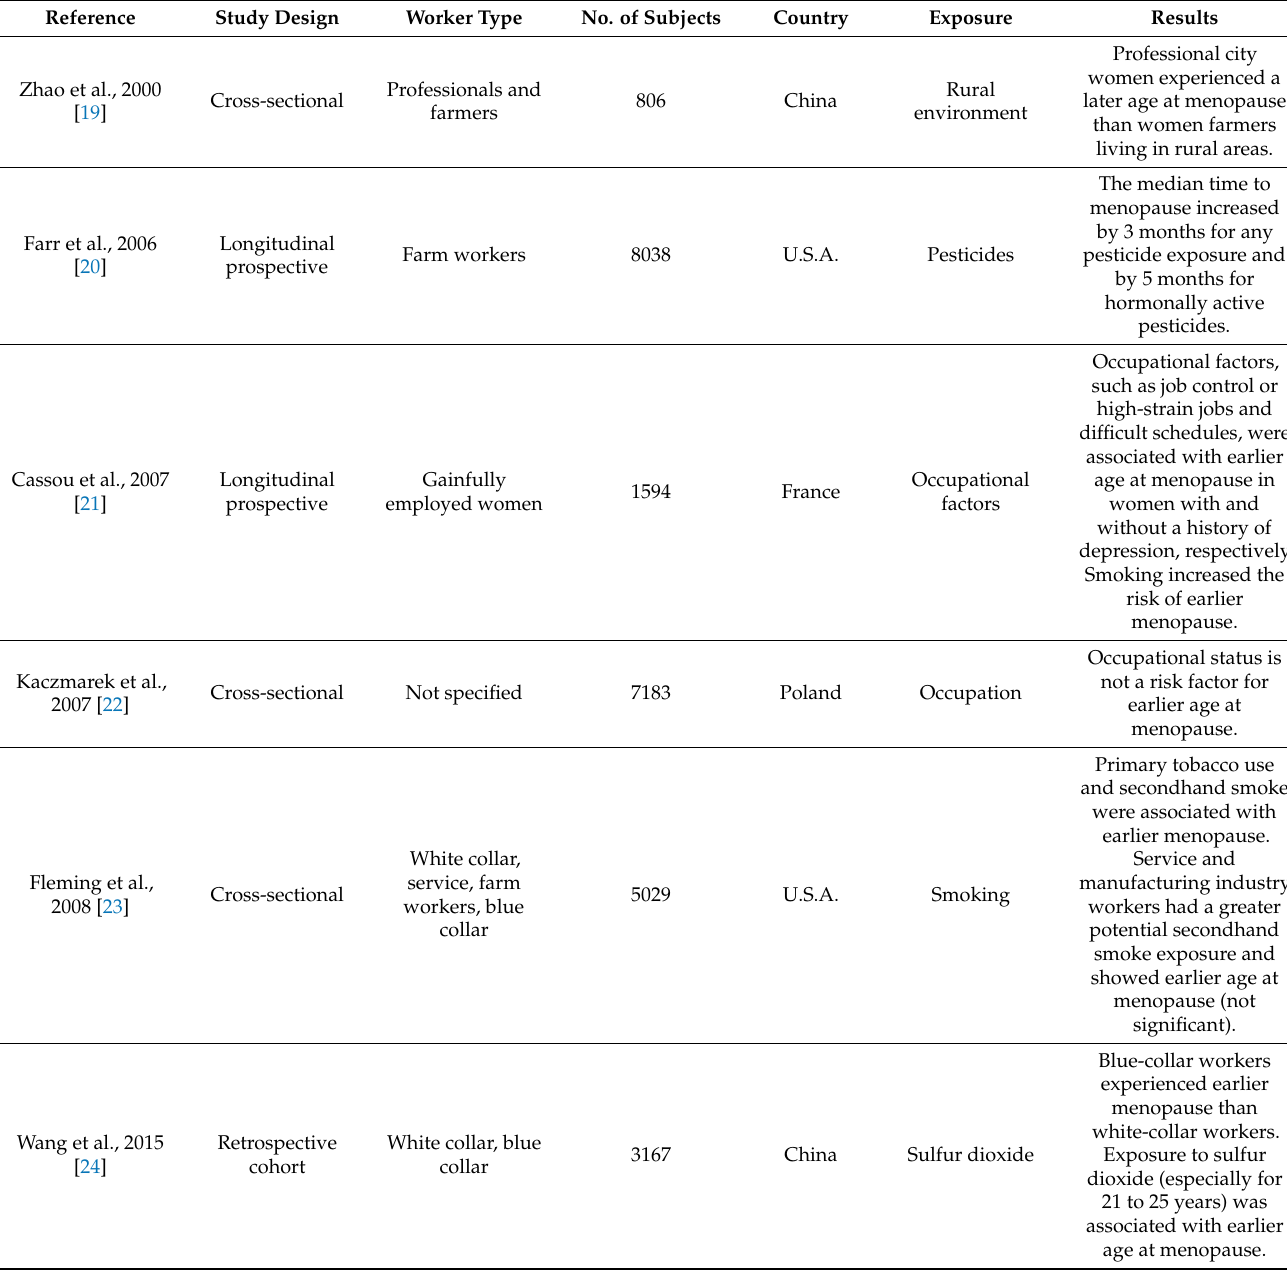
Table 3. Studies evaluating work and age at